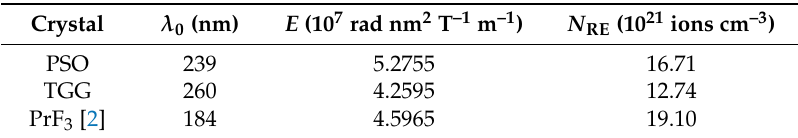
Table 2. The fitted results of PSO, TGG, and PrF 3 single crystals according to Equation (1), and the respective RE 3+ ion concentrations N RE in the